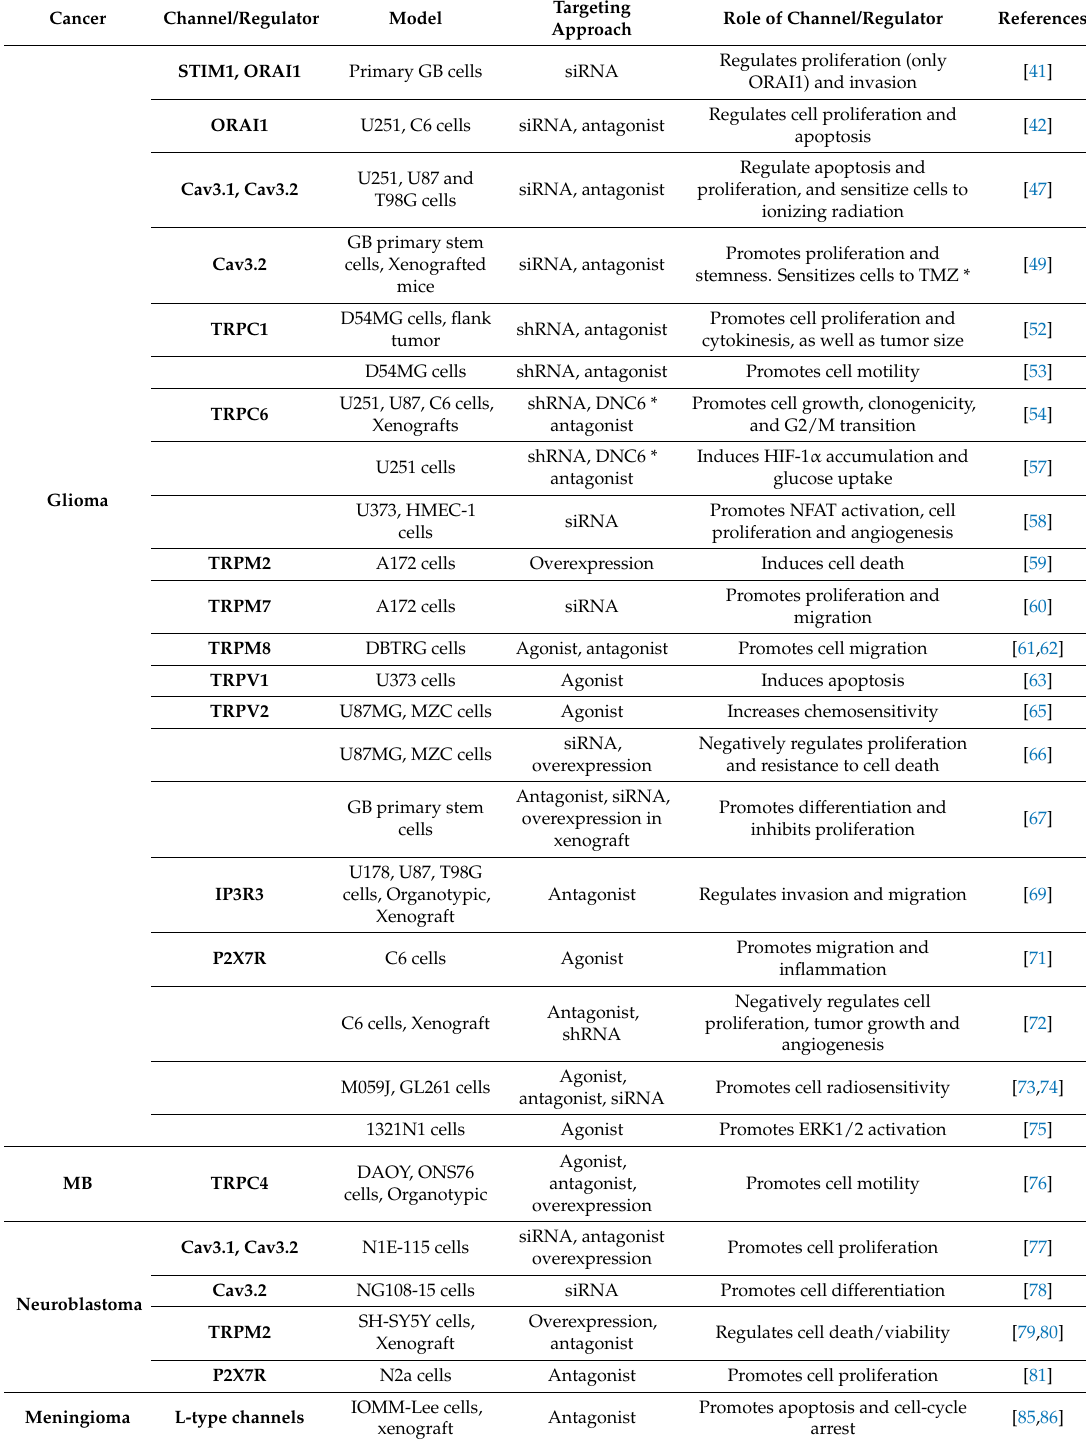
Table 1. Ca 2+ -transporting proteins with demonstrated specific roles in brain